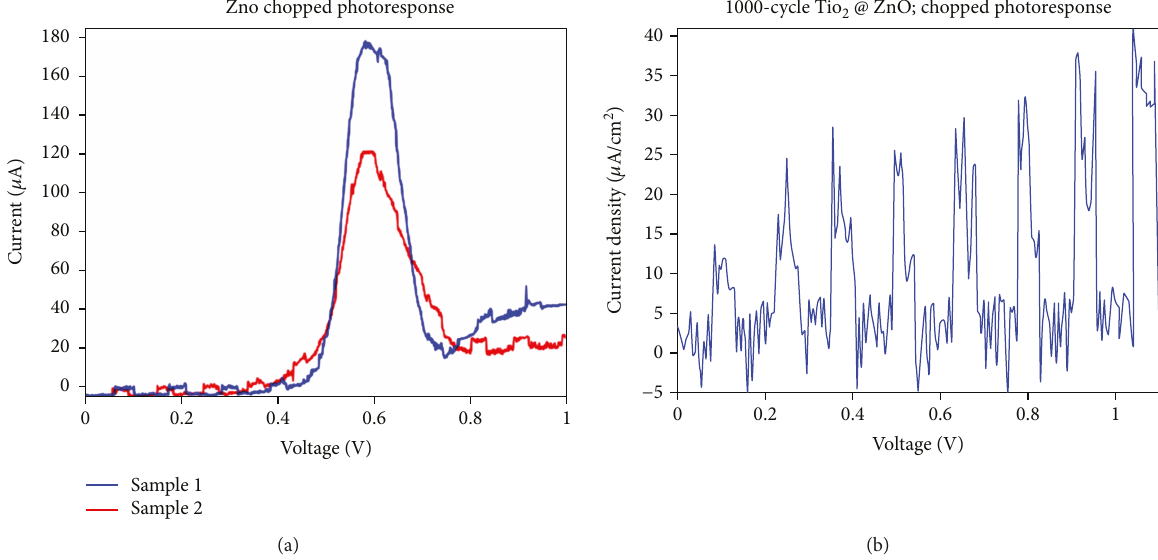
Figure 9: Chopped scans (alternating dark and lit conditions) for (a) bare ZnO nanowires. As can be seen by the linear sweep, hydrothermally grown ZnO nanowires exhibit undesirable side reactions, which obscure photocurrent and compromise stability of the device. In contrast, (b) 1000-cycle TiO shows no such reactions and signi fi cant di ff erence between on/o ff 2